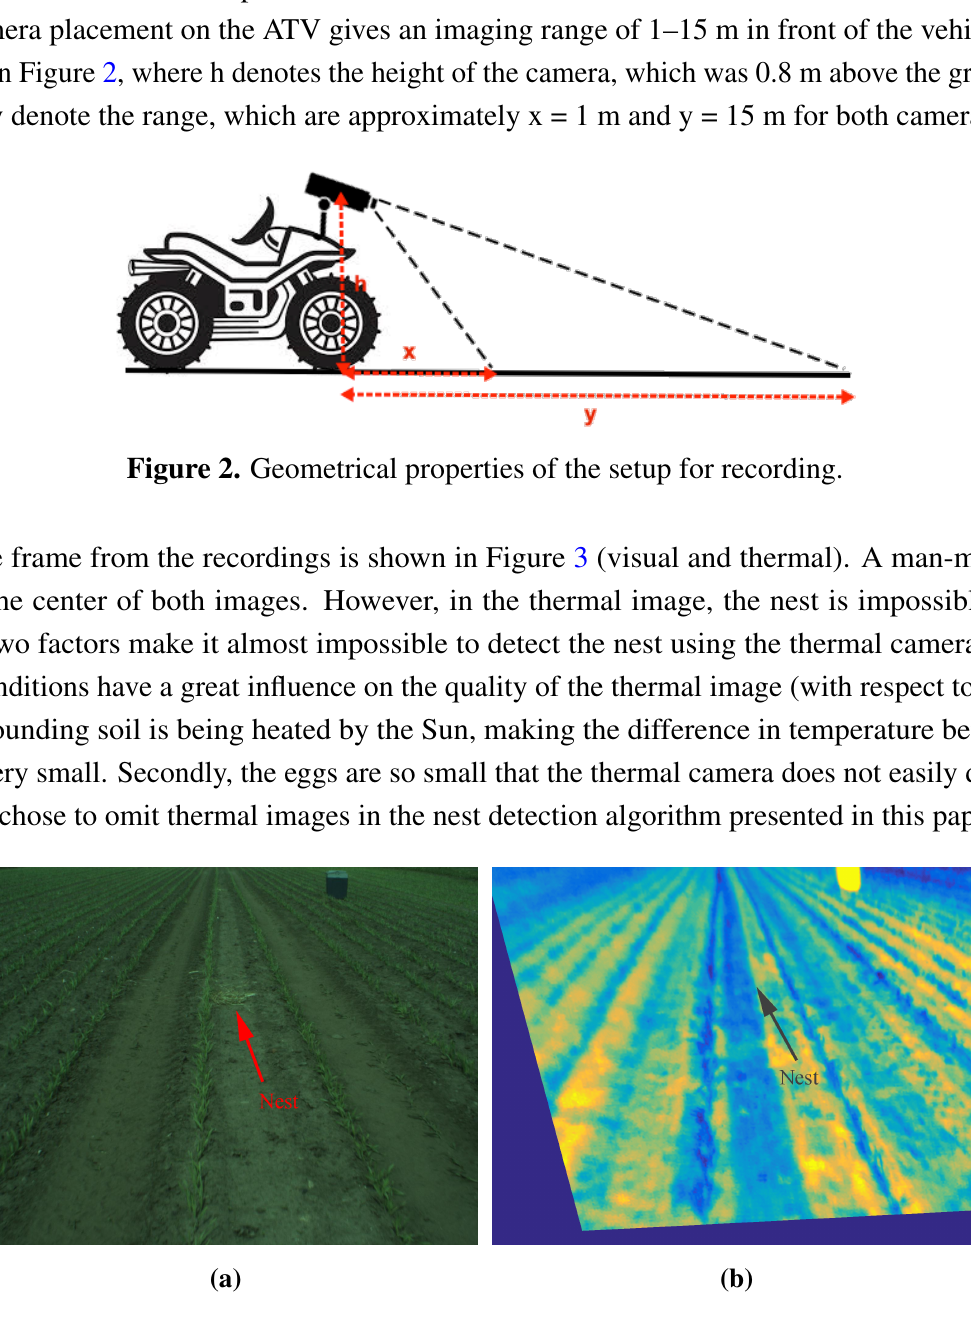
Figure 3. Images captured by the RGB and thermal camera. ( a ) Visual image of the